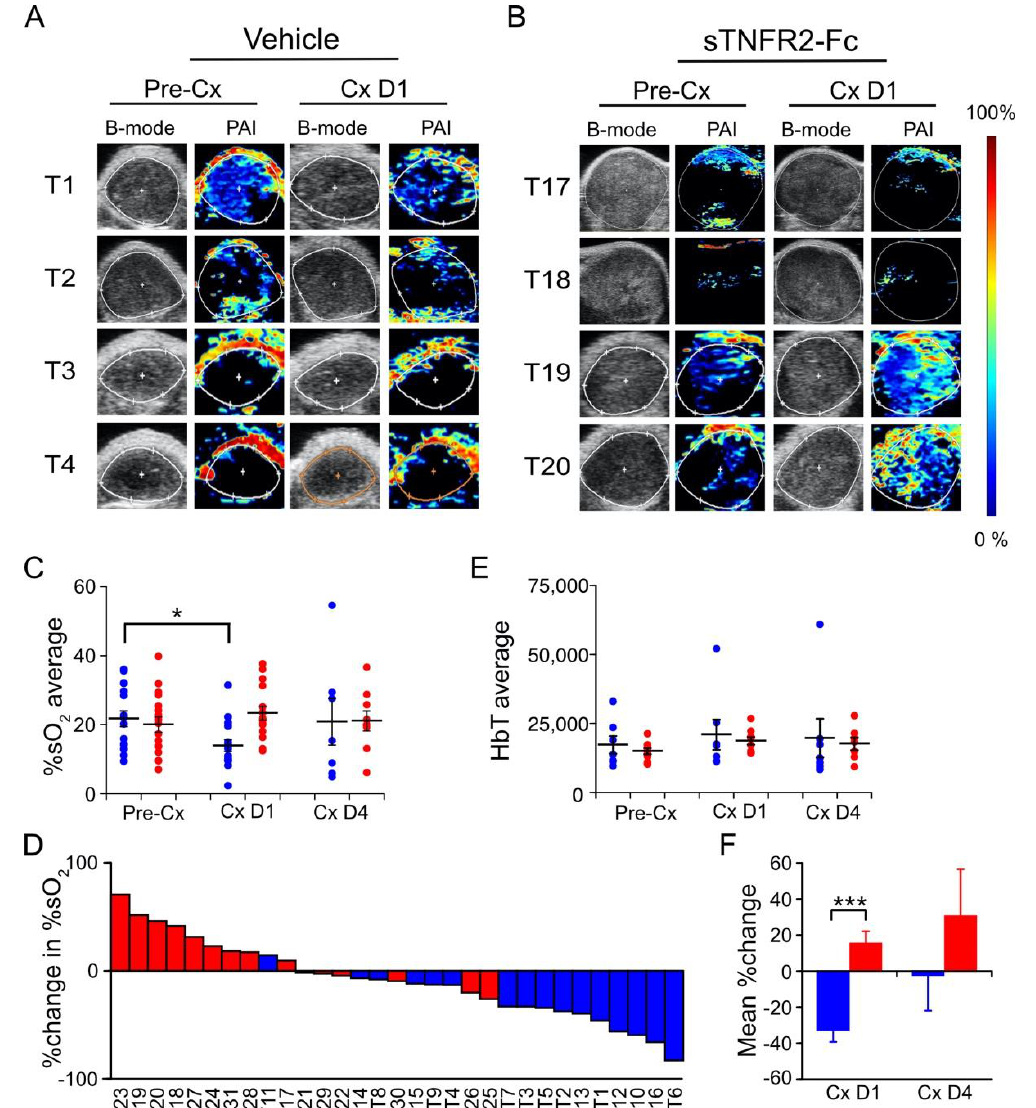
Figure 4. Castration-induced hypoxia in Myc-CaP tumor is reversed by TNF signaling blockade. ( A , B ) Photoacoustic images (PAI, pseudo-colored) and ultrasound (B-mode) of Myc-CaP subcuta- neous tumors in four tumors from each group, pre- and post-castration from vehicle-treated mice ( A ) or sTNFR2-Fc-treated mice ( B ). ( C ) Mean PAI signal (%sO 2 , large bars) from tumors pre-castration (n = 16), and at one (n = 15) and four (n = 9) days post-castration in vehicle-treated (blue) or in sTNFR2-Fc-treated (red) mice. PAI signal from each tumor indicated by closed circles. ( D ) Waterfall plot of change in %sO 2 in individual tumors at one day post-castration versus pre-Cx (columns). ( E ) Mean total hemoglobin (large bars) from tumors pre-castration (n = 16), and at one (n = 16), and at four (n = 14) days post-castration in vehicle-treated (blue) or sTNFR2-Fc-treated (red) mice. PAI signal of each tumor indicated by closed circles. ( F ) Mean change in paired measures of %sO 2 pre-castration versus D1 or D4 post-castration. Mean (columns) and SEM (bars). * p < 0.05, *** p < 0.001.